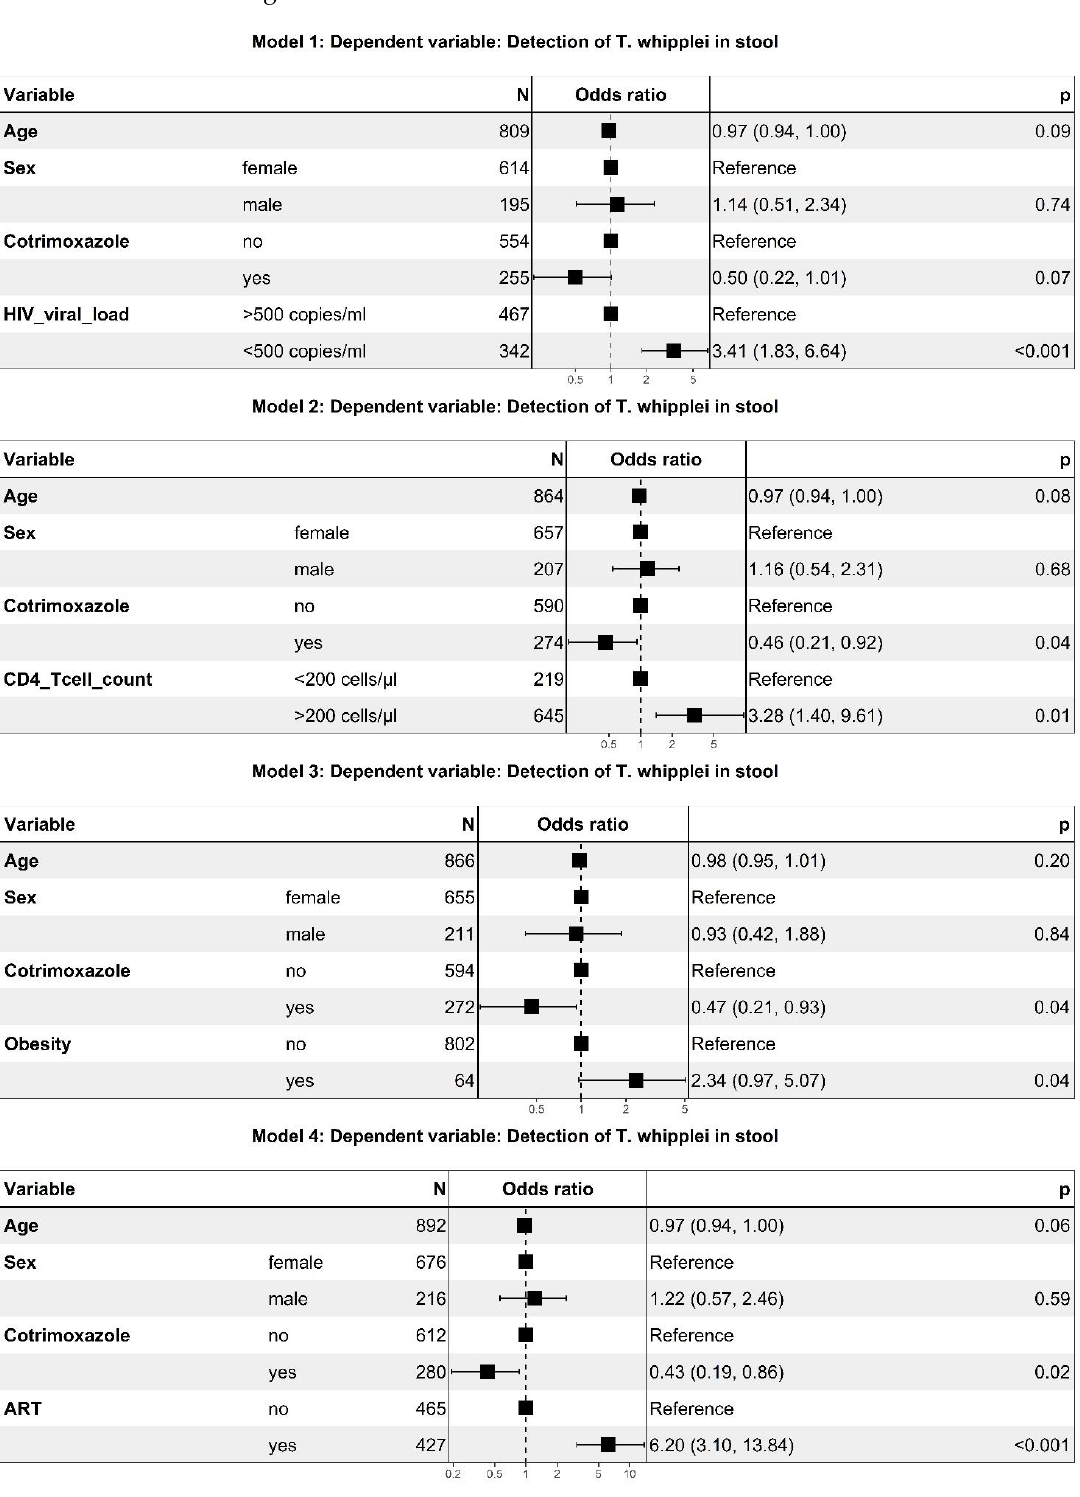
Figure 3. Factors associated with T. whipplei carriage in HIV positive participants. Multiple logistic regression models displaying odds ratios (95% confidence intervals) and adjusted p -values of independent variables. Obesity defined as BMI > 30 kg/m². ART—antiretroviral therapy.